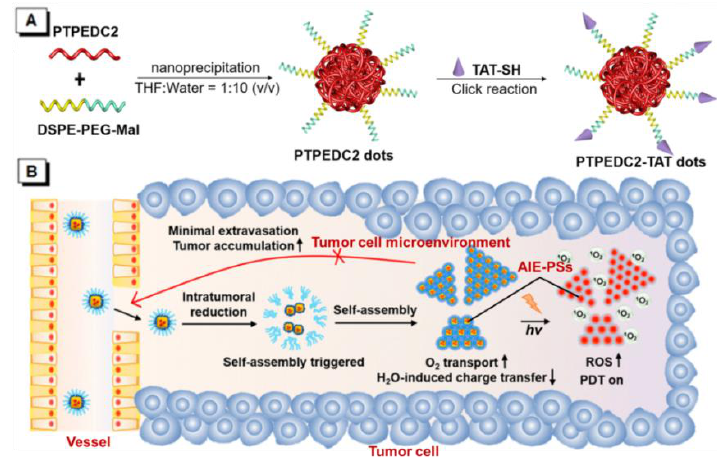
Figure 6. ( A ) Schematic illustration for the synthesis of AIE–PS dots and Aggregation-induced emission trans-activating protein (AIE-TAT) PS dots using PTPEDC2 as an example. Adapted and modified with permission from reference 50 (copyright 2019, American Chemical Society). ( B ) Schematic illustration of in vivo self-assembly of nanoparticle 8 . Adapted and modified with permission from reference 53 (copyright 2020, American Chemical